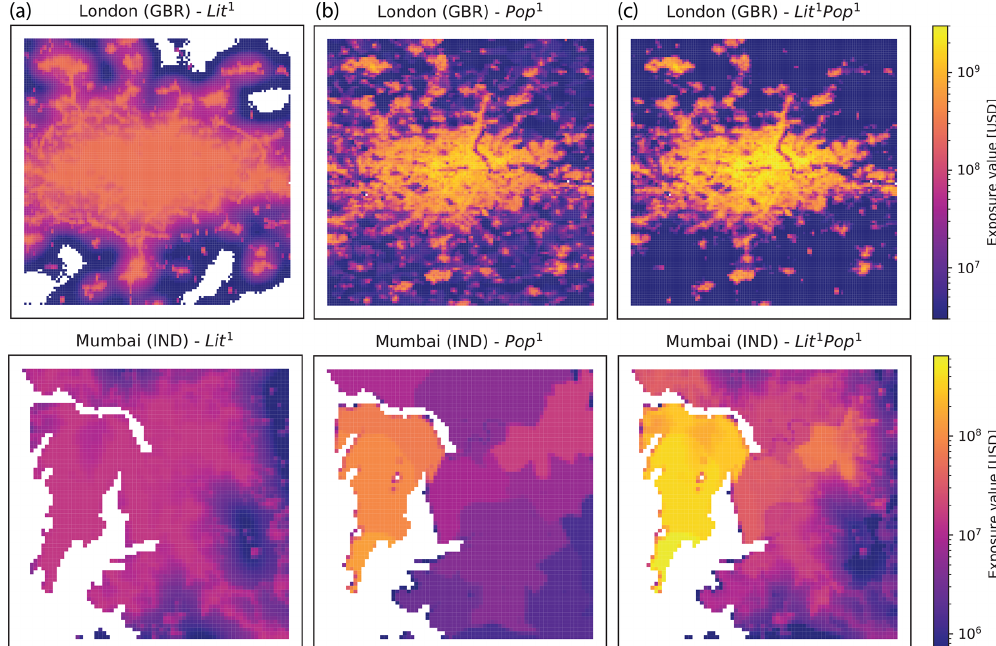
Figure 4. Maps of disaggregated asset exposure value. Values are spatially distributed proportional to nightlight intensity of 2016 (Lit 1 , a ), population count as of 2015 (Pop 1 , b ), and the product of both (Lit 1 Pop 1 , c ) for metropolitan areas in the United Kingdom (GBR) and India (IND). The maps are restricted to the wider metropolitan areas of London (51–52 ◦ N, 0.6 ◦ W–0.4 ◦ E) and Mumbai (18.8–19.4 ◦ N,